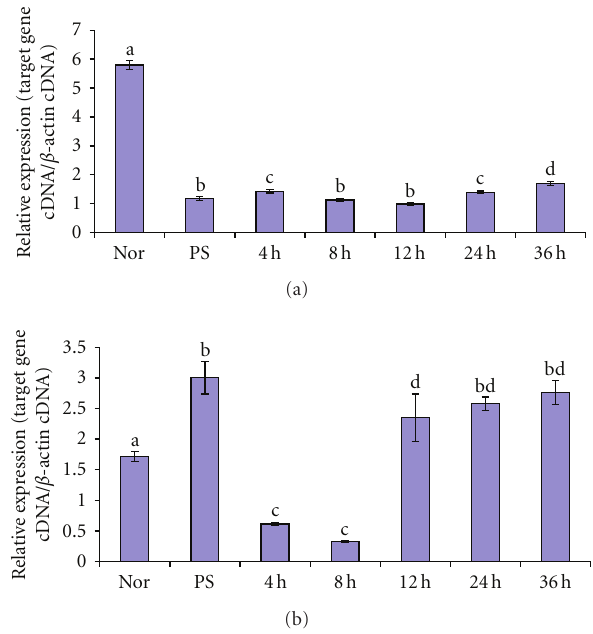
Figure 4: Expression profiles of the CXCR4 gene in di ff erent tissues of turbot using real-time PCR at di ff erent times after challenged with V. harveyi (4, 8, 12, 24 and 36hours). (a) head kidney; (b) spleen. Nor: noninjected fish; PS: PS-injected fish. The expression level was analyzed by one-way ANOVA followed by Duncan’s test. Groups marked with the same letters are not statistically di ff